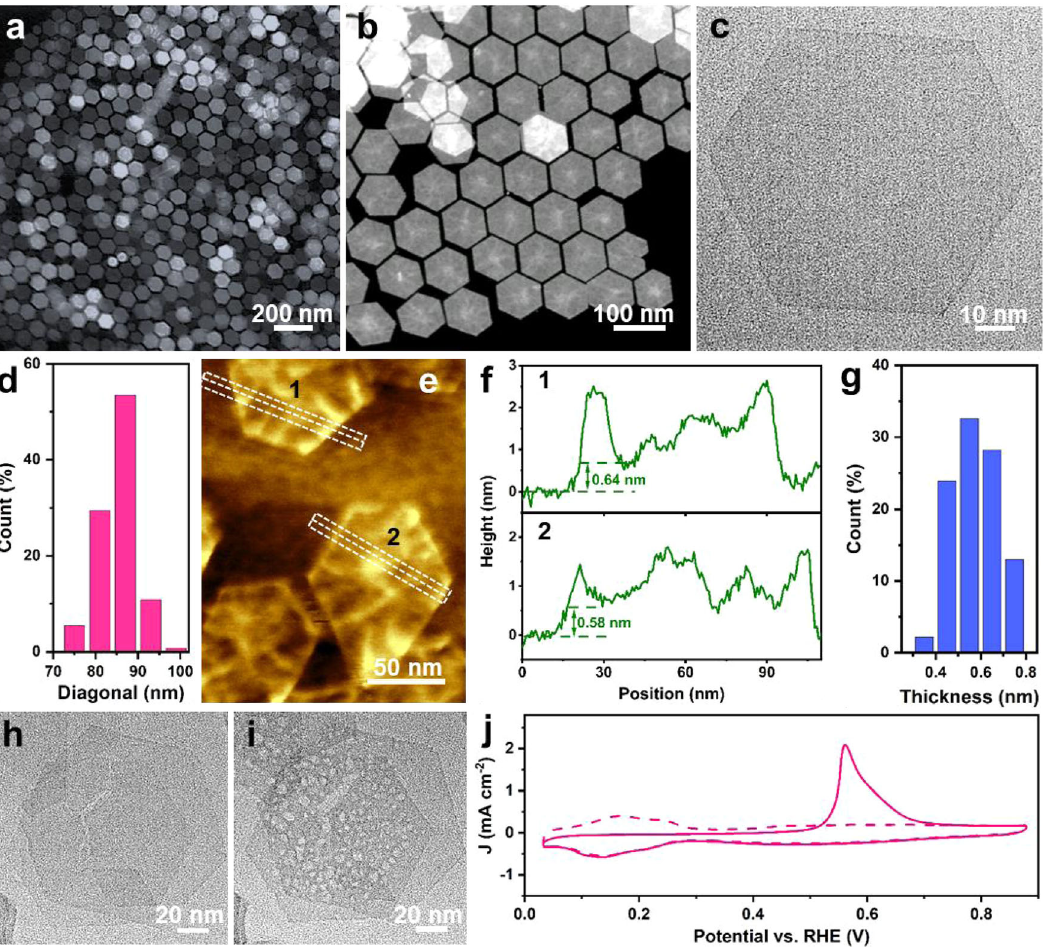
Fig. 1 | Morphology characterizations of RhMo NSs. a , b HAADF-STEM images, c TEMimage, d diagonallengthdistribution, e AFMimagewith f thecorresponding height pro fi les and g thickness distribution of RhMo NSs. TEM images after